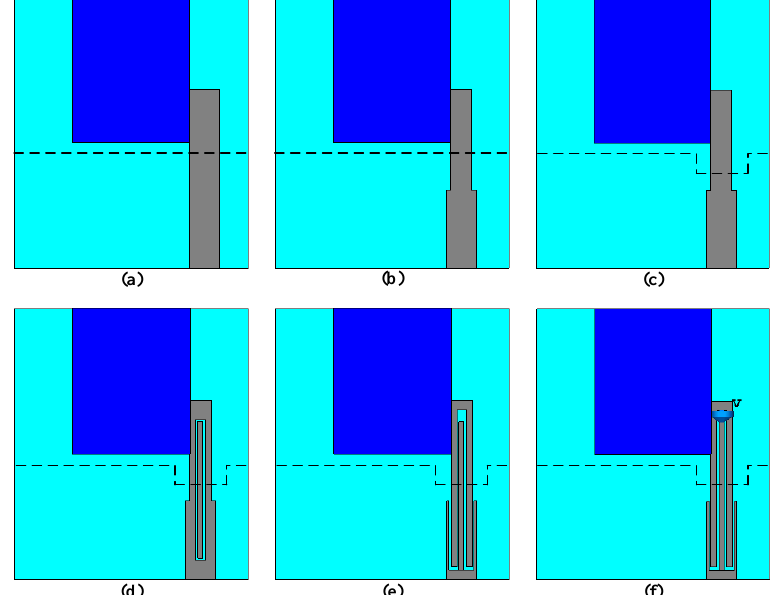
Figure 2. Evolution process of the proposed antenna: ( a ) Antenna I; ( b ) Antenna II; ( c ) Antenna III; ( d ) Antenna IV; ( e ) Antenna V; and ( f ) Antenna VI.